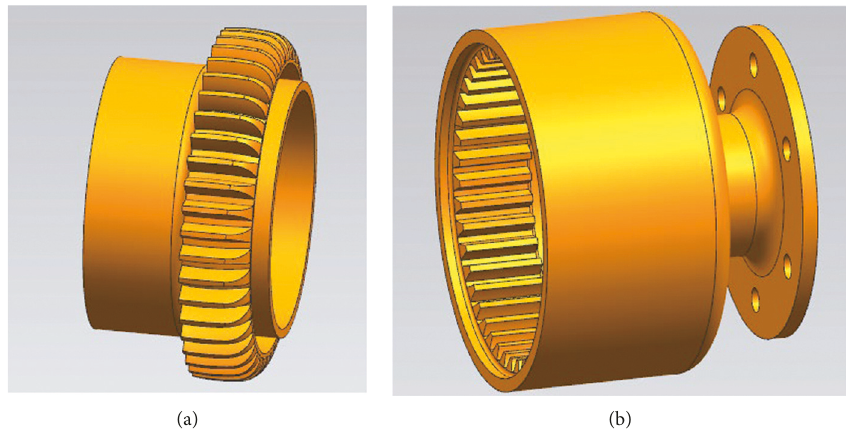
Figure 7: Three-dimensional model of drum gear coupling. (a) The solid model of the drum tooth disk. (b) The solid model of the output